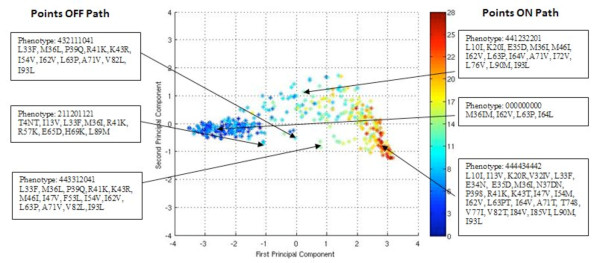
Projection of the phenotypic data onto its first and second principal components. Points are colored by the total number of amino acid substitutions relative to the consensus B WT sequence, according to the scale at right; a mixture at a position (including those containing the WT amino acid) is counted as one substitution. The phenotypes and genotypes of selected sequences are indicated. The 9-digit shorthand phenotypic code used to describe the sequences indicates the resistance score (Table 2) to each of the 9 PIs in the order shown in Fig. 1: RTV, NFV, ATV, APV, IDV, LPV, SQV, TPV, DRV. All "outlying" sequences are fully listed in Supplementary Information (Fig. S4, Additional File 1).